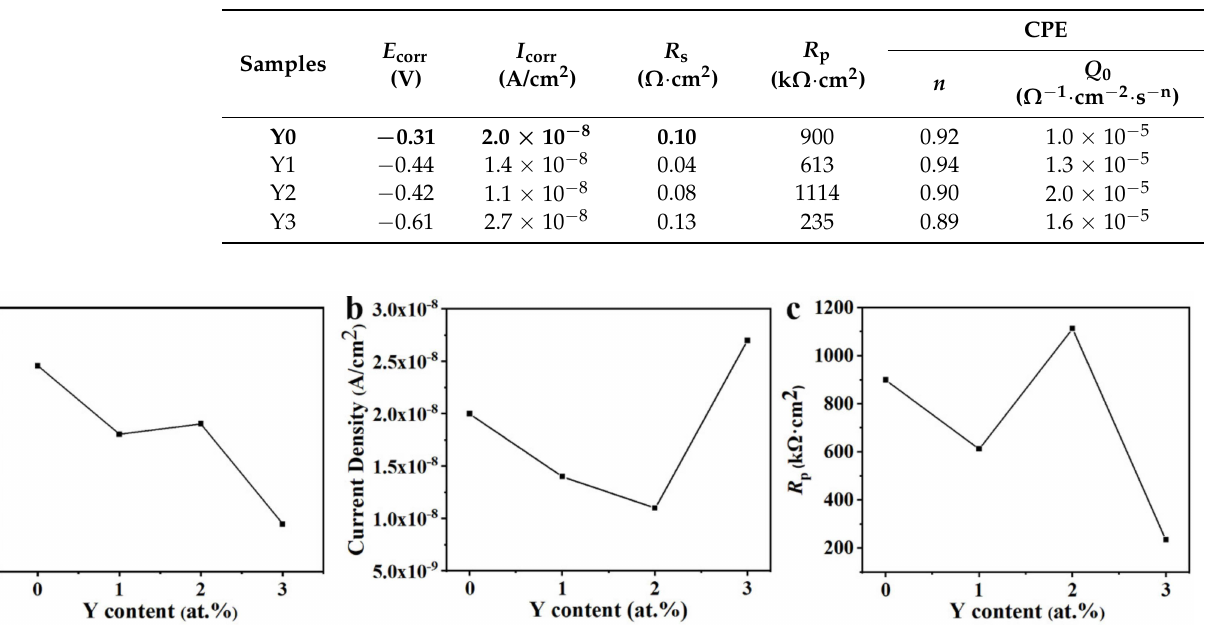
Figure 8. ( a ) Plot of E corr vs. yttrium doping content, ( b ) plot of I corr vs. yttrium doping content, and ( c ) plot of R p vs. yttrium doping